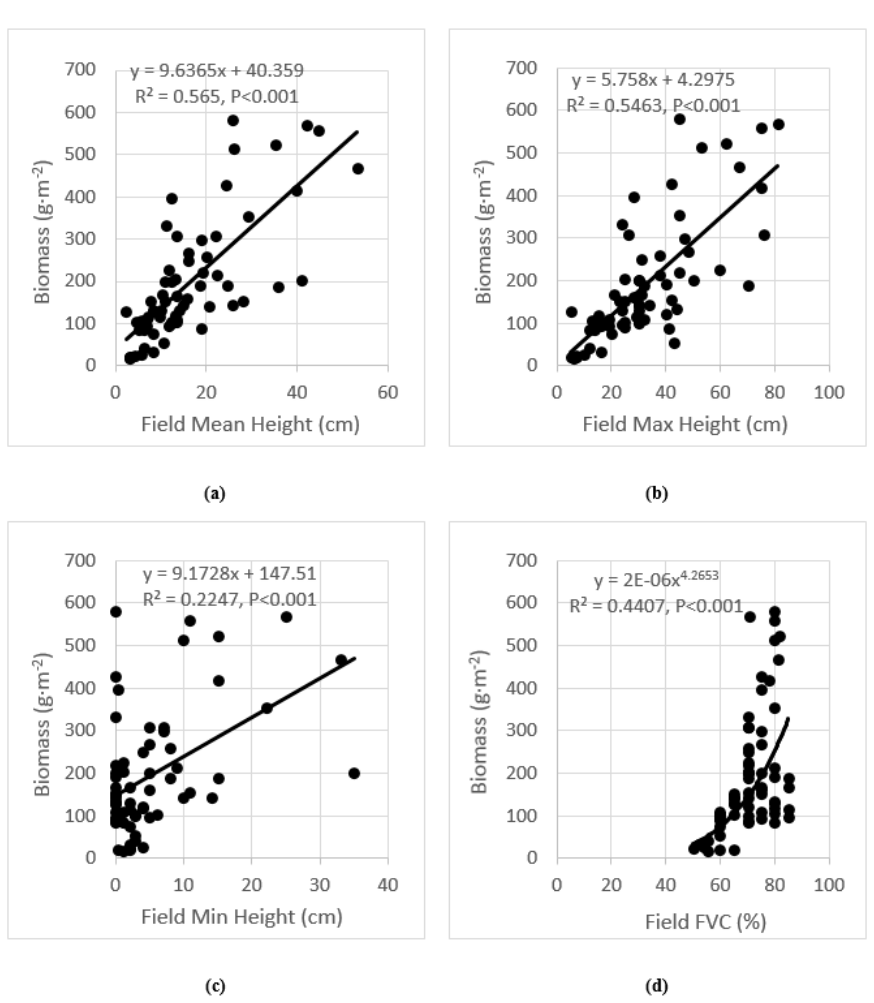
Figure 6. Relationships of biomass with the field-measured mean canopy height ( a ); maximum canopy height ( b ); minimum canopy height ( c ); and fractional cover ( d ). R 2 of regression models were calculated from the 66 training samples.